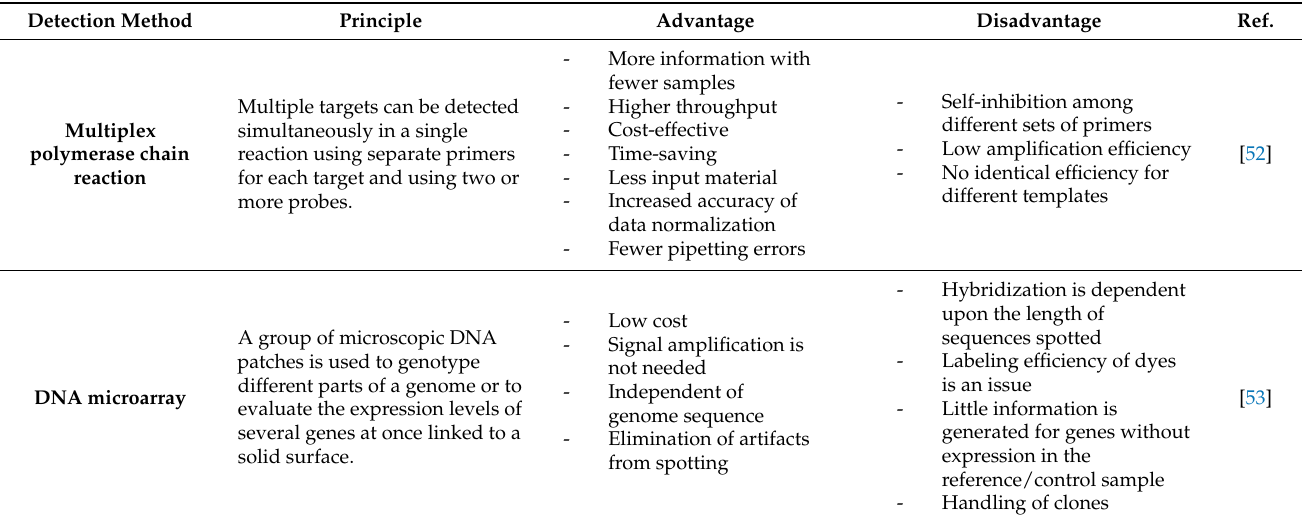
Table 1. Conventional detection methods of K. pneumoniae